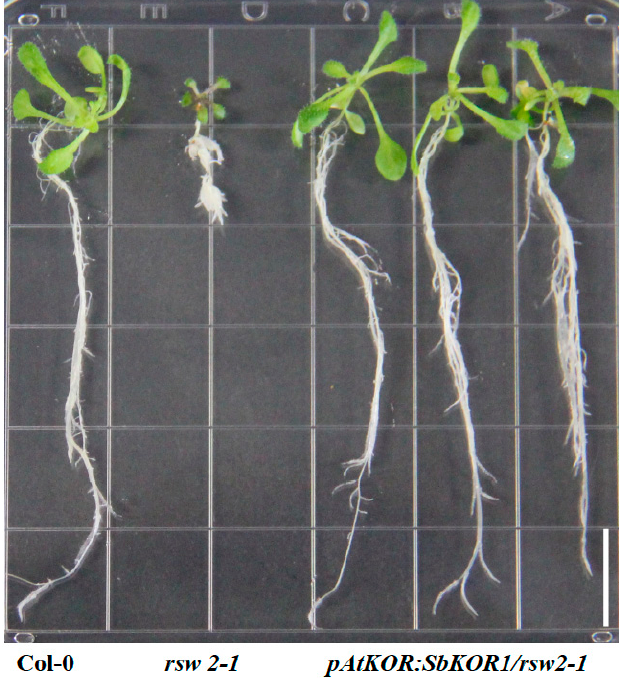
Figure 5. Rescue of phenotype. Arabidopsis complemented lines with rsw2-1 mutant and Col-0. Scale bar 1 cm.